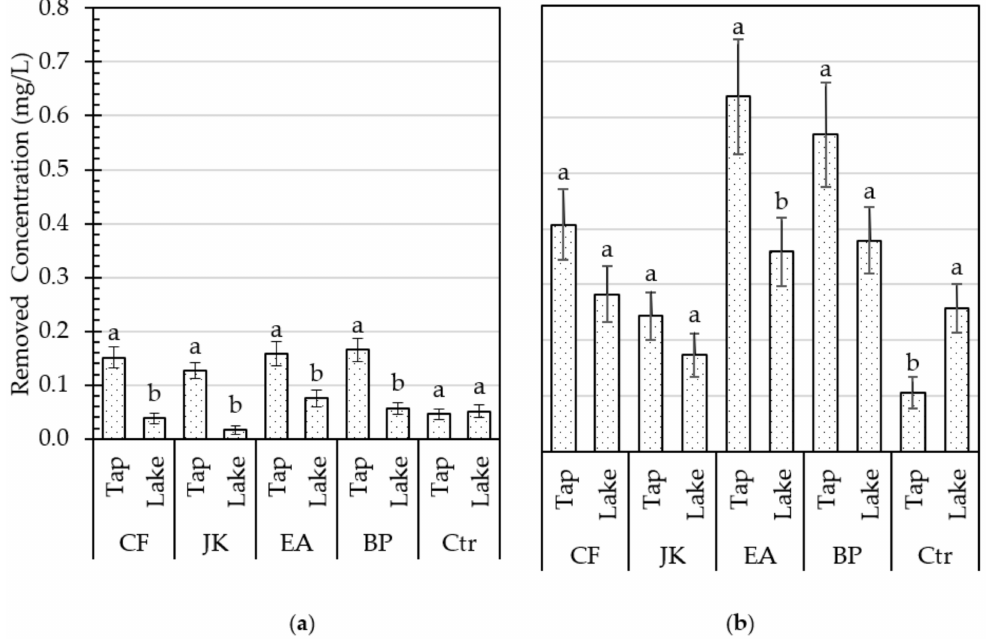
Figure 2. ( a ) Copper, ( b ) Zinc. Mean removal of metals in nutrient-deficient (tap) and nutrient-rich (lake) water. Comparison was performed between tap water and lake water only for the same treatment by Mann-Whitney U nonparametric test. Values sharing a common letter label for the same treatment are not statistically